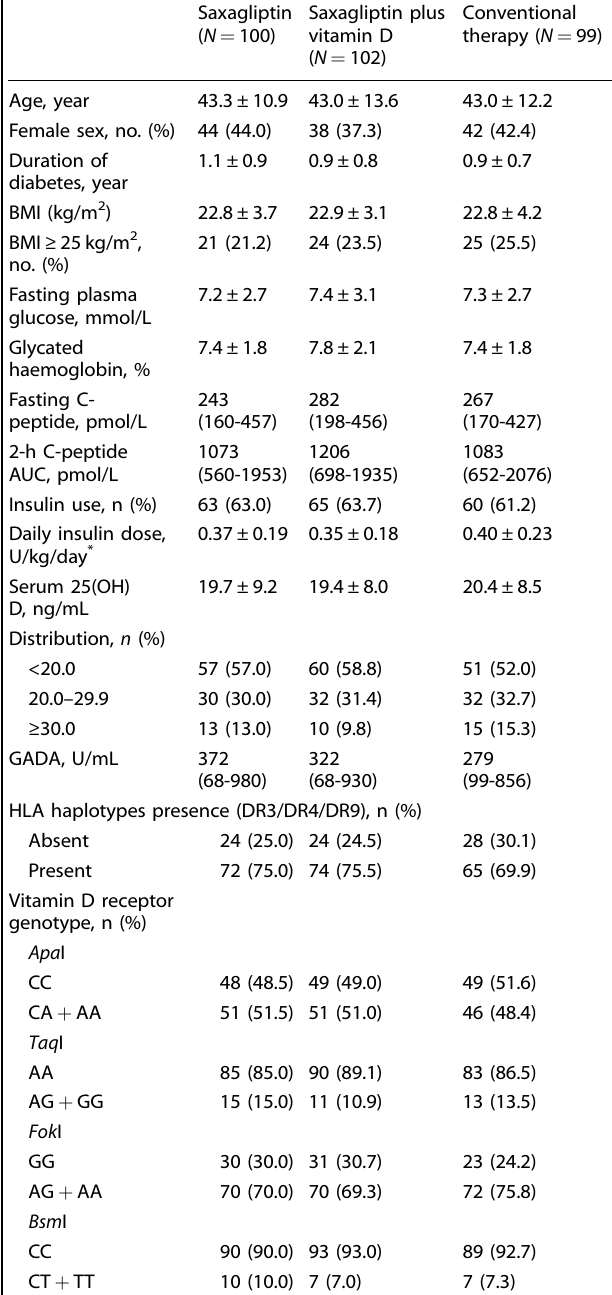
Table 1. Baseline Characteristics of the Participants Saxagliptin ( N =